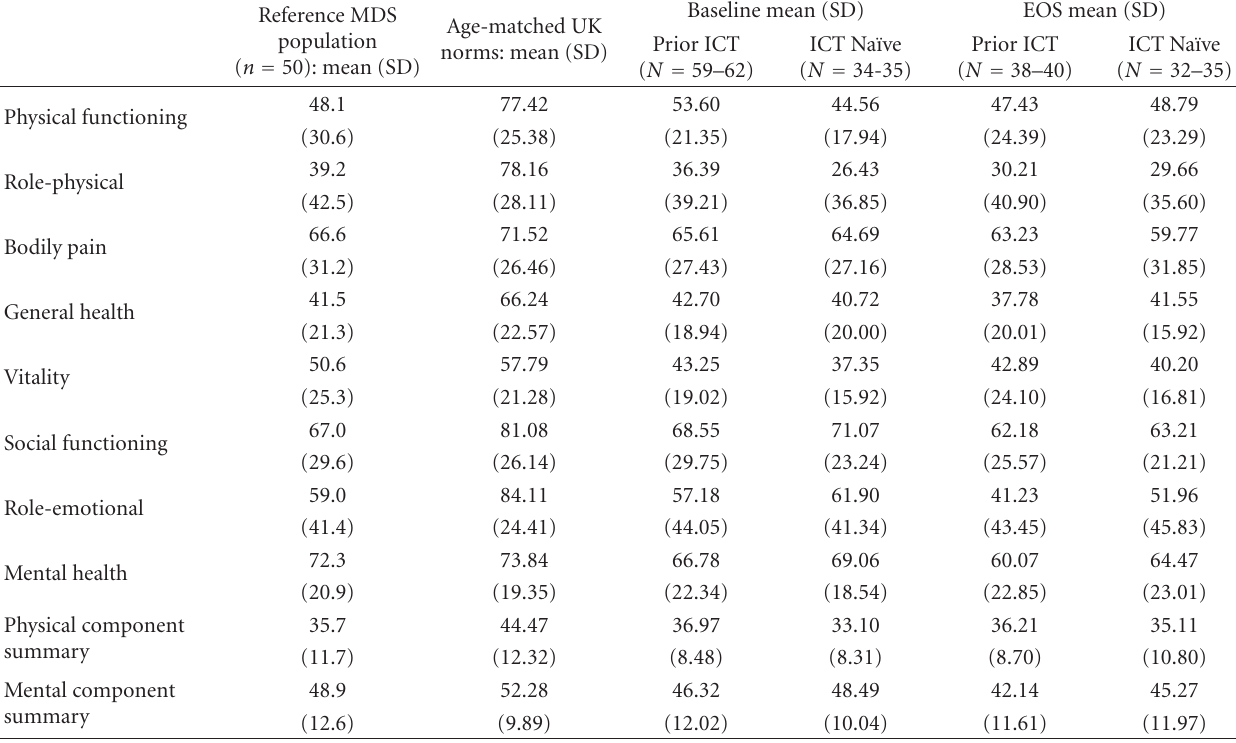
Table 2: Mean (SD) SF-36 domain and summary scores among MDS patients according to prior ICT